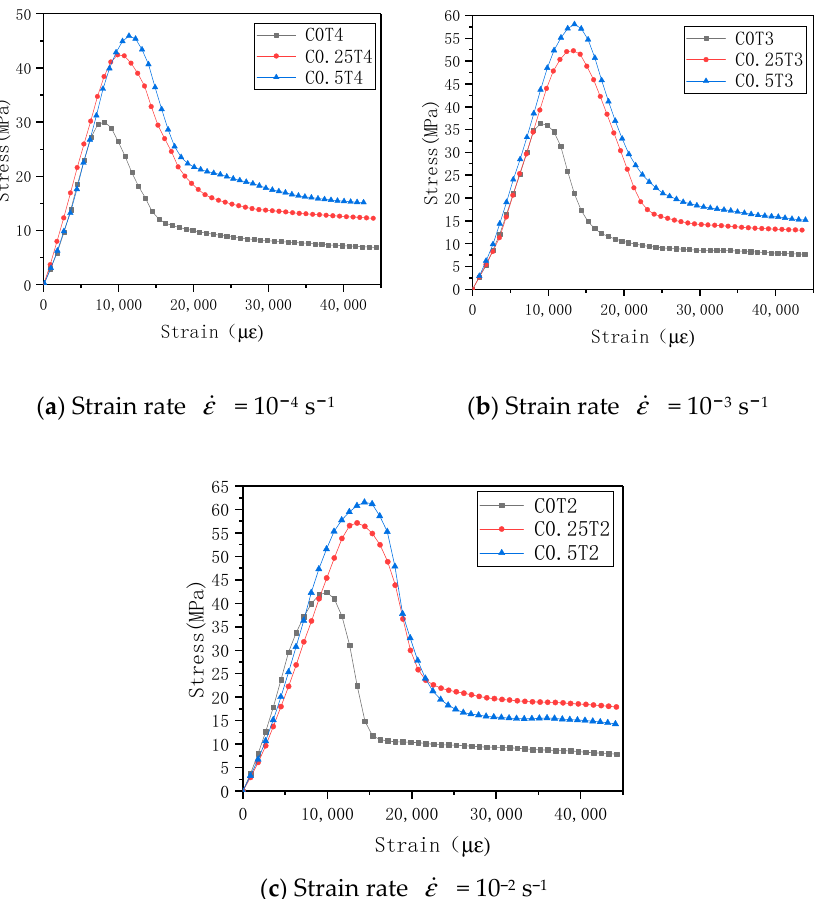
Figure 11. Average stress-strain curves at different lateral pressure levels corresponding to different strain rates. (2) Constitutive relationship The ECC compressive stress-strain curves at different lateral pressure levels and strain rates are normalized based on the peak stress and peak strain. The normalized curve is shown in Figure 12. The shape of the curve under different lateral pressure and different strain rates is similar and can be described by the same set of fittings. According to the curve form, a two-stage formula is selected for fitting, see Equation (8).